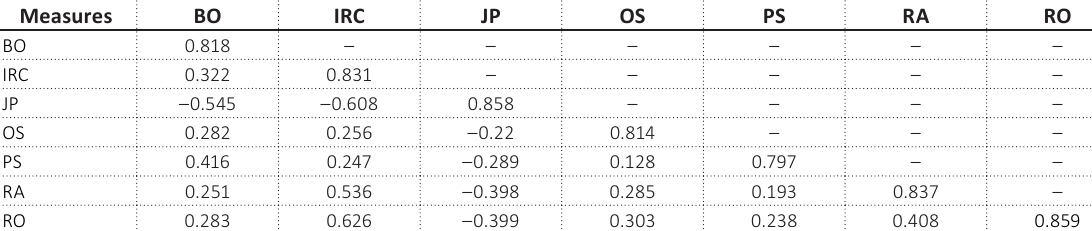
Table 3. Fornell-Larcker